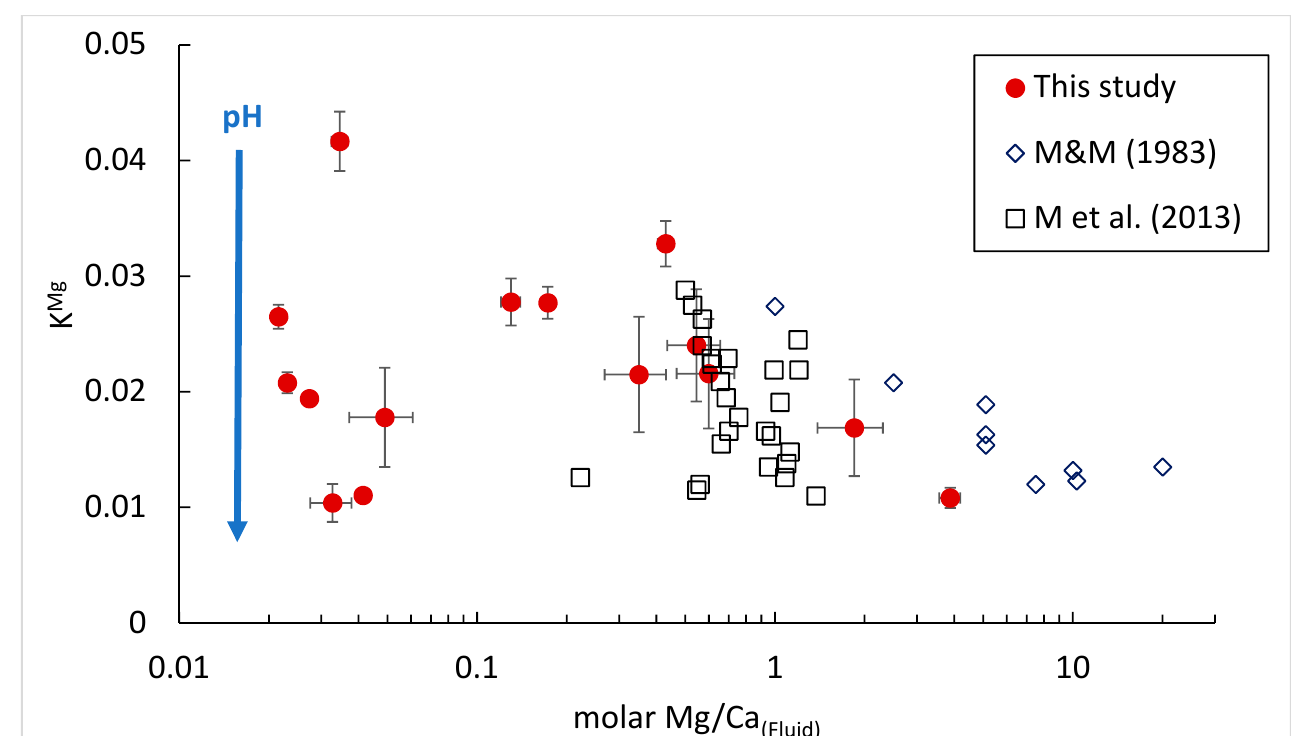
Figure 7. A log–linear plot demonstrating the relationship between aqueous Mg/Ca and K Mg . Red circles represent data from the present study, blue diamonds are data from Mucci and Morse [18], and grey squares are data from Mavromatis et al. [15]. The analytical uncertainty for Mg/Ca (Fluid) in the present study was determined in terms of the standard error. K Mg analytical uncertainty in the present study was determined using the formula: √ ((Mg/Ca (Solid) Error) 2 /(Mg/Ca (Fluid) ) 2 + (Mg/Ca (Fluid) Std.dev) 2 /(Mg/Ca (Fluid) ) 4 ·(Mg/Ca (Solid) ) 2 ). The method for determining analytical uncertainty was not reported by Mavromatis et al. [15]. The blue arrow indicates a negative effect of pH on K Mg . Using the values for Mg/Ca (Solid) and averaged Mg/Ca (Fluid) , K Mg was calculated (see